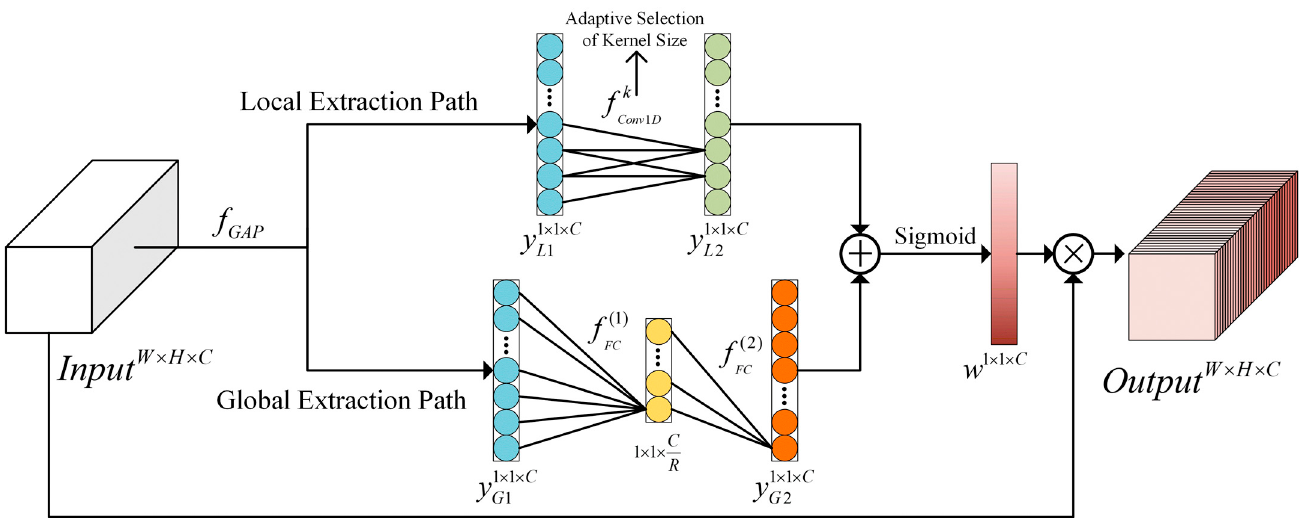
Figure 6. The structure of the proposed DCA Block.